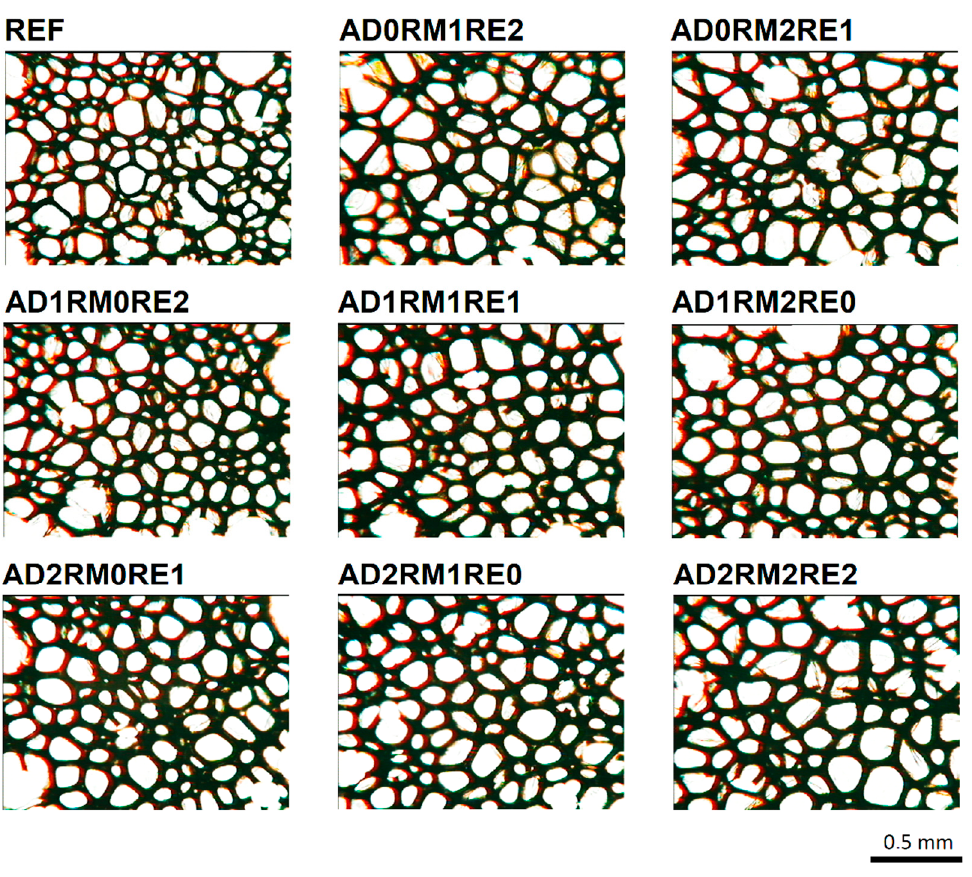
Figure 4. Microphotographs of the foam cell structure in the cross-section perpendicular to the foam rise direction. Table 3. Closed-cell content of the obtained polyurethane foams and average cell density. Foam